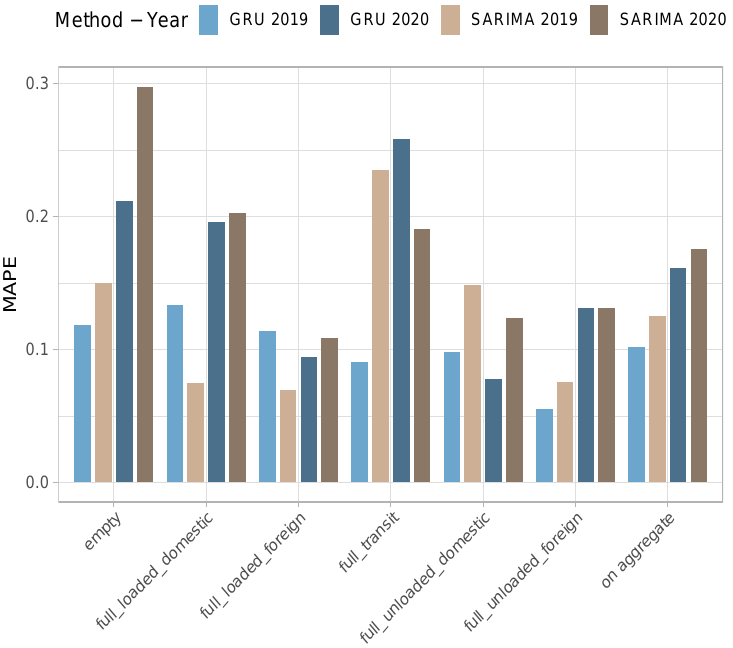
Figure 6. Performance of the SARIMA and GRU models expressed as MAPE for forecasting years 2019 (lighter) and 2020 (darker).